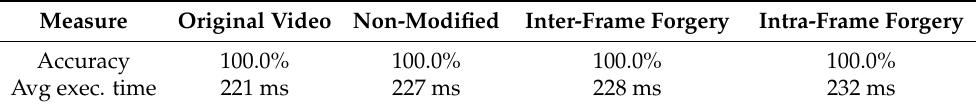
Table 1. Accuracy and execution time of integrity